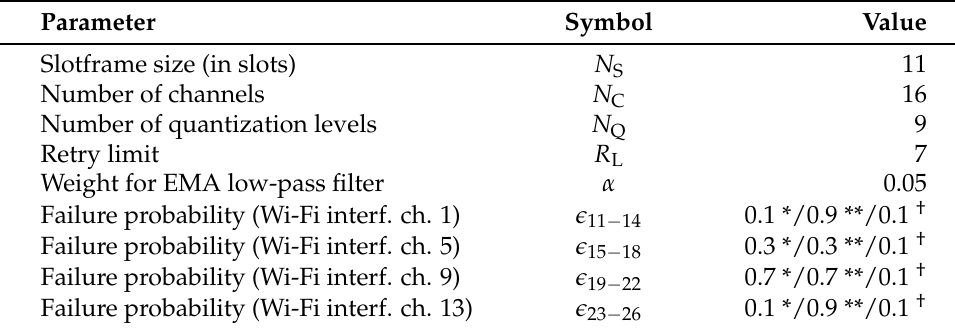
Table 3. Parameters used in the experiments (protocol and environmental).